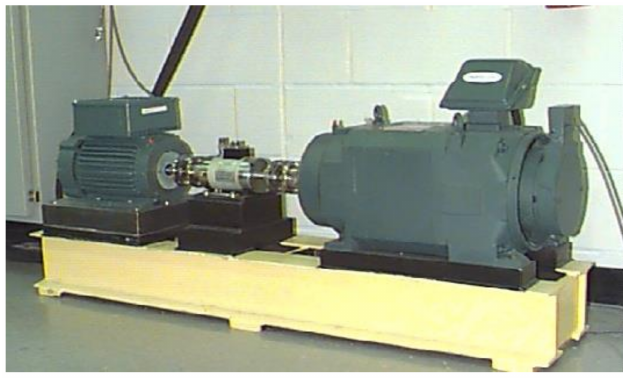
Figure 5. Motor driving mechanical system used by CWRU.